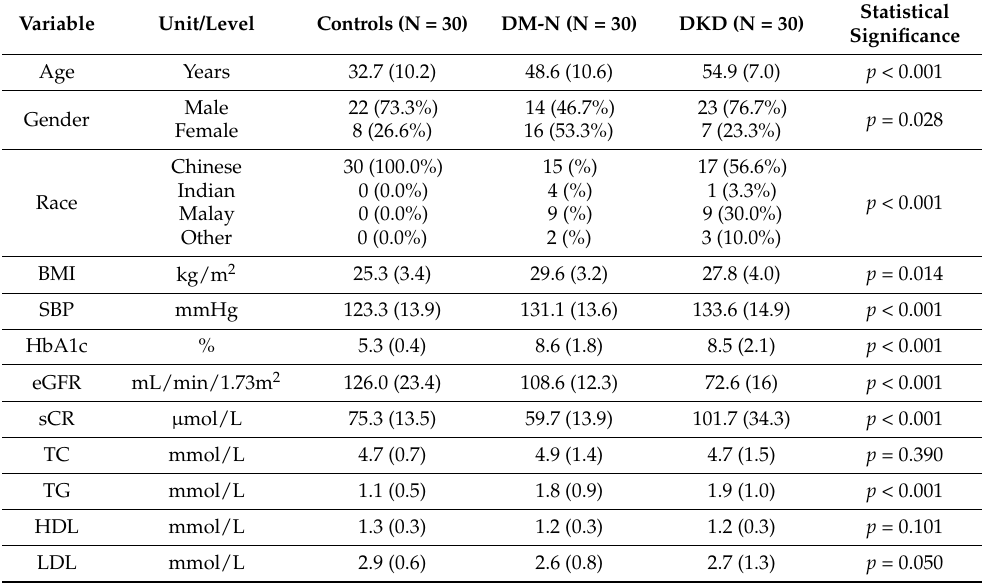
Table 1. Patient characteristics and clinical biochemistry values in the controls, subjects with diabetes mellitus (DM) and normal renal function (DM-N), and subjects with diabetic nephropathy (DKD).